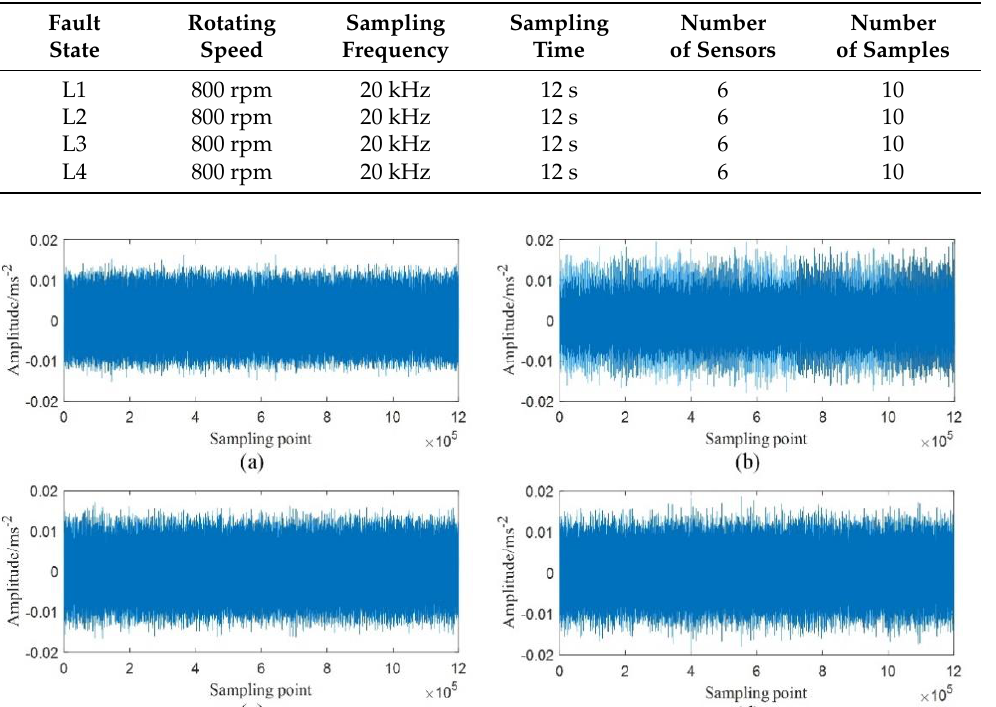
Table 2. The datasets of the failures.